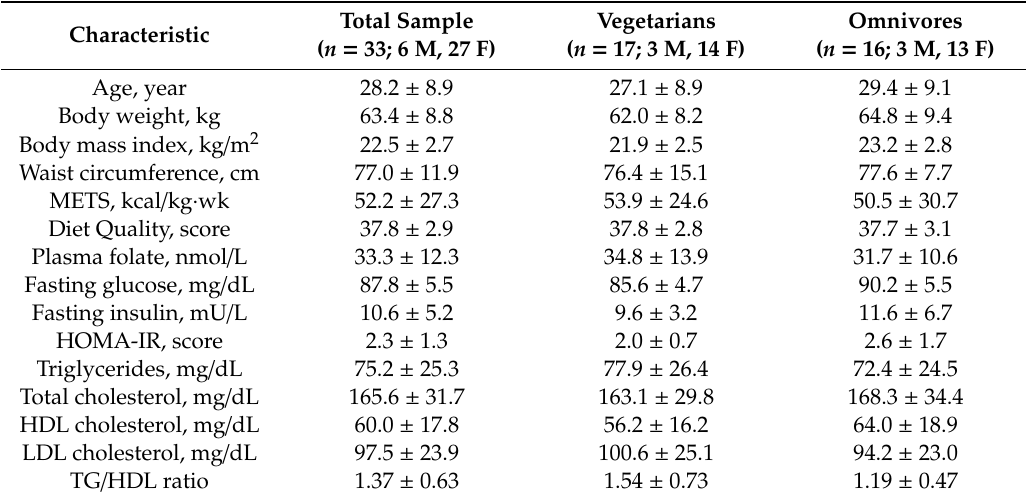
Table 1. Participant characteristics 1